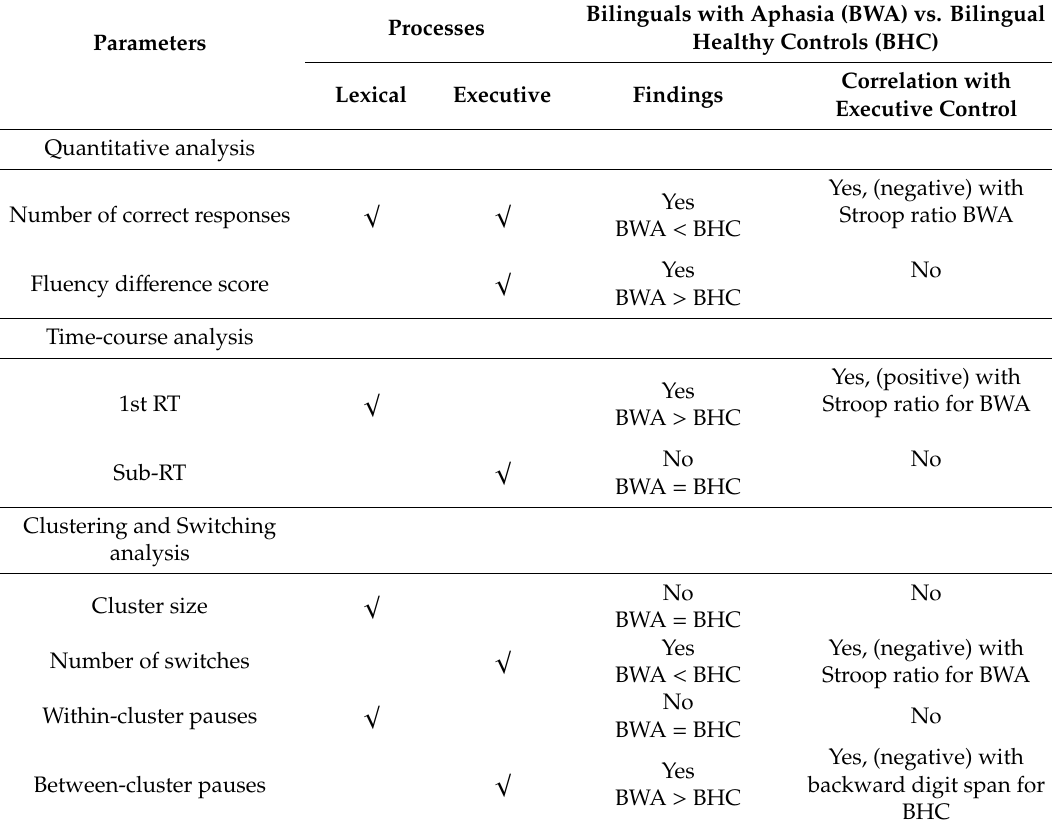
Table 8. Results of the current study in the context of the verbal fluency variables and their lexical and executive control components. The bold fonts indicate significant e ff